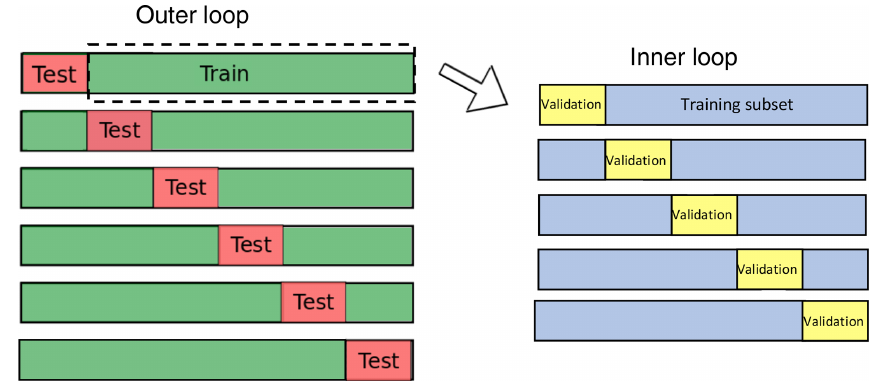
Figure 6. Cross-validation approach used to evaluate the performance of the machine-learning models considered in this